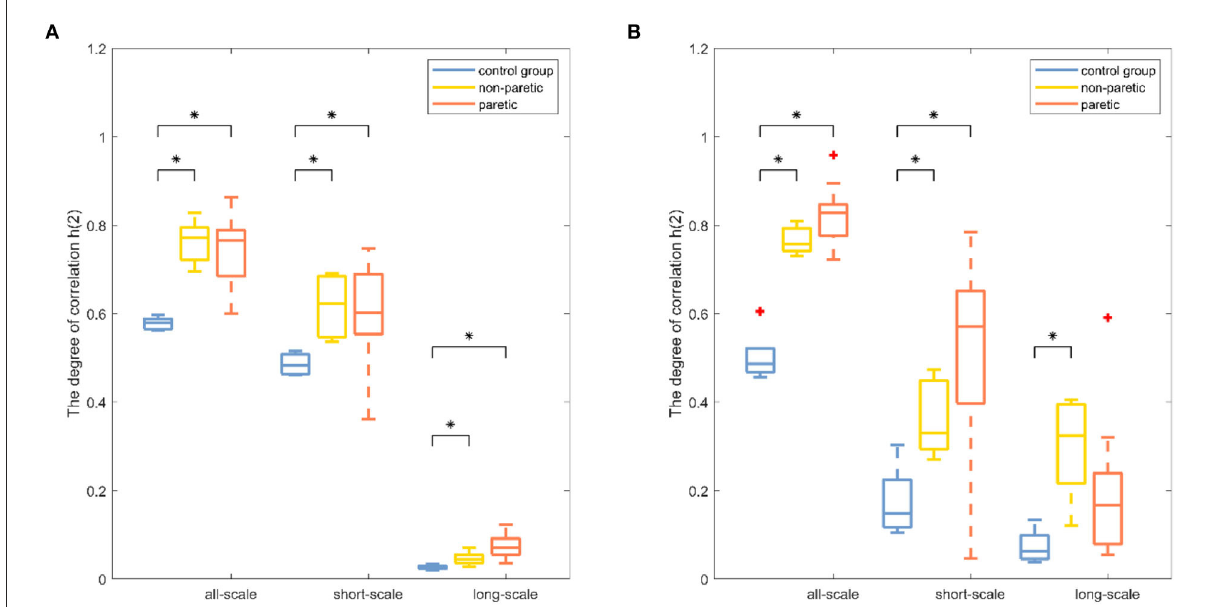
FIGURE4 Boxplots of the fractal fluctuation results among the paretic limbs and the non-paretic limbs of a patient with stroke and the control group under three conditions (all-scale; short-scale; long-scale) during treadmill-walking tasks. Boxplots show the quartiles, the medians, and the ranges of the individual results. Outliers are indicated with + signs. * Indicates statistically significant difference at a p − value < 0.05 .